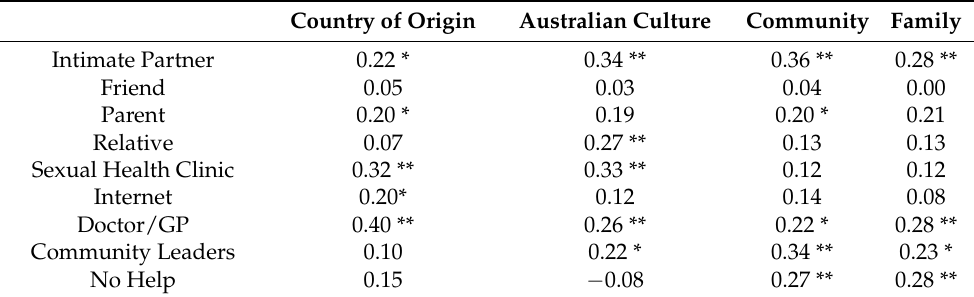
Table 3. Bivariate correlations between measures of cultural connectedness and sources of sexual and reproductive health (SRH) help-seeking.